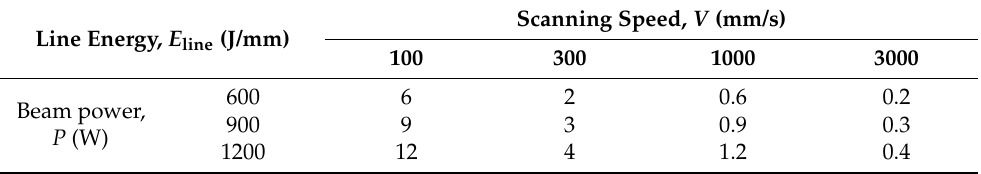
Table 1. Electron-beam irradiation